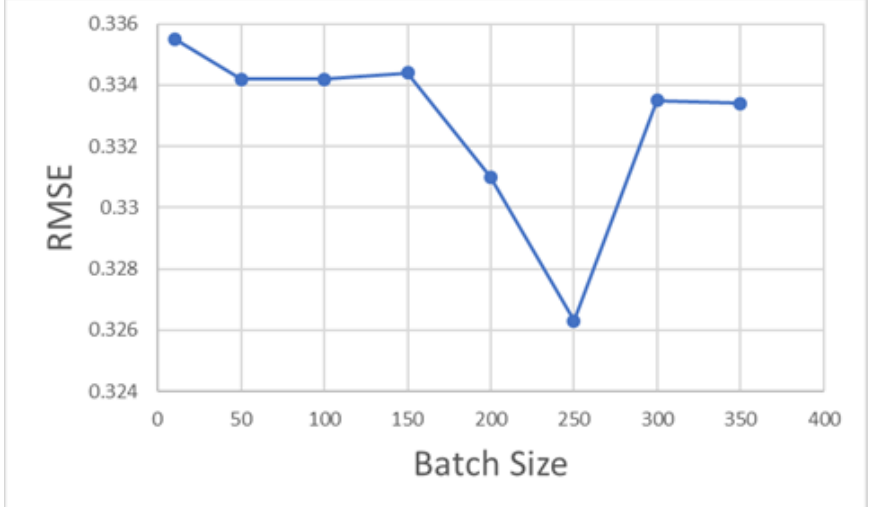
Figure 7. Effect of different batch sizes on model accuracy.